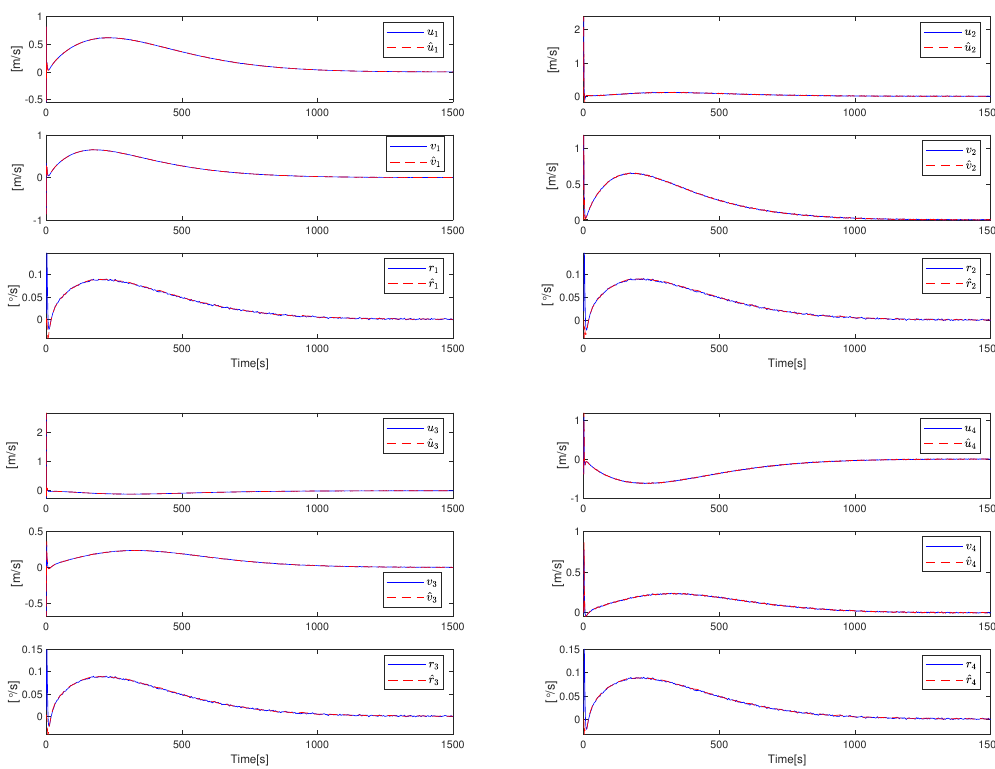
Figure 7. Velocities and estimations of four